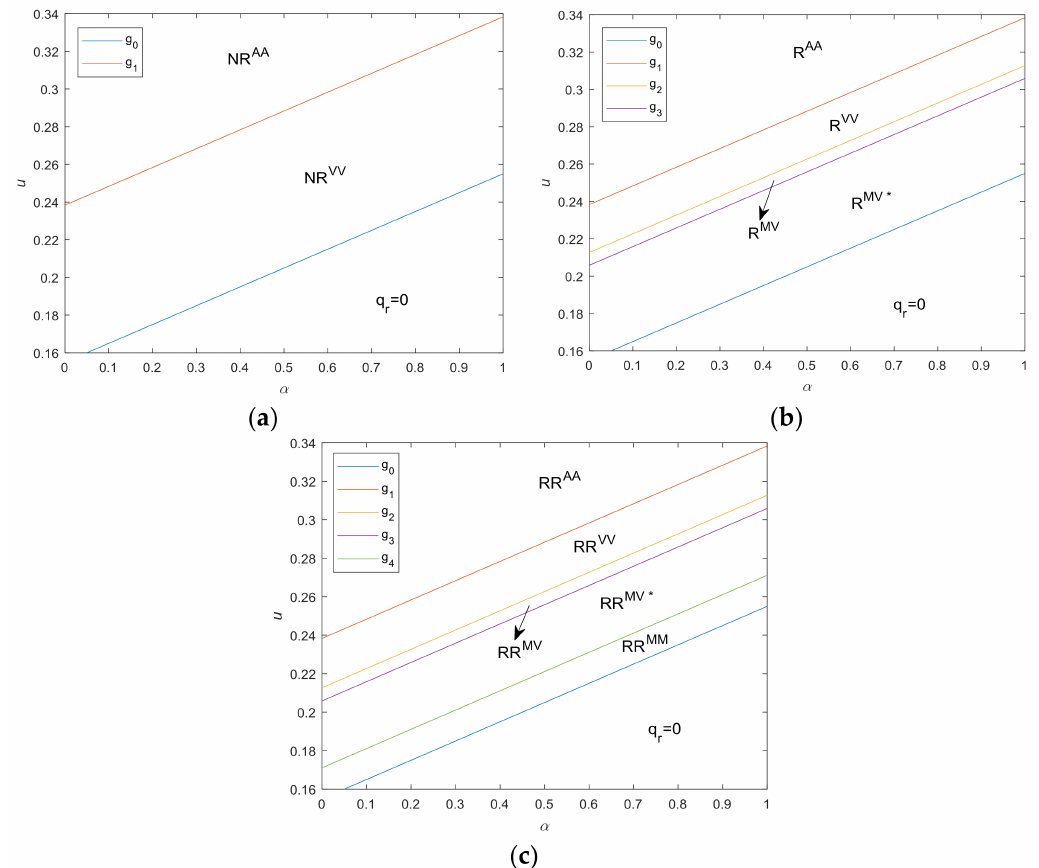
Figure 3. Optimal strategies under cap-and-trade regulation. ( a ) no take-back regulation; ( b ) under take-back regulation only with collection target; ( c ) under take-back regulation with both collection and remanufacturing targets. (Note, c n = 0.4, c c = 0.05, δ = 0.5, e = 0.5, ε = 0.2, τ c = 0.6, τ r =